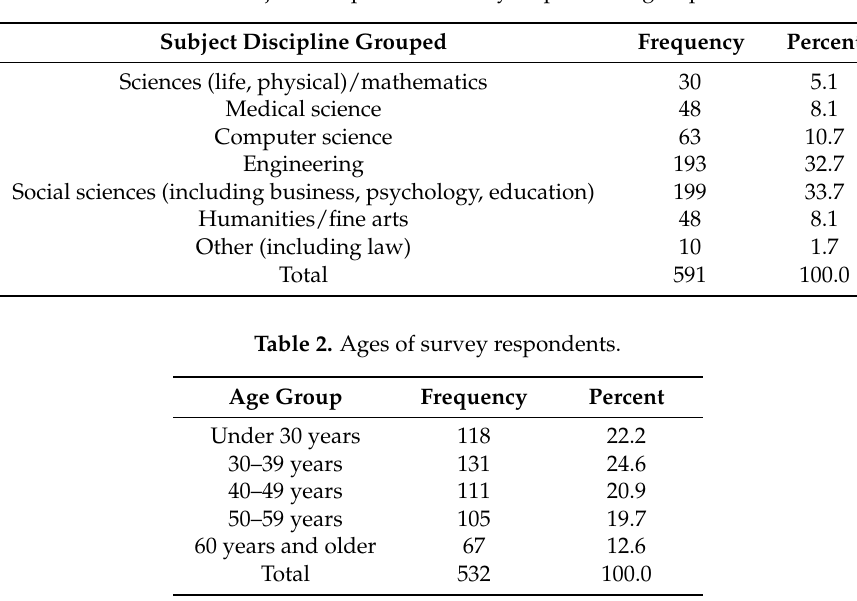
Table 1. Subject disciplines of survey respondents grouped.